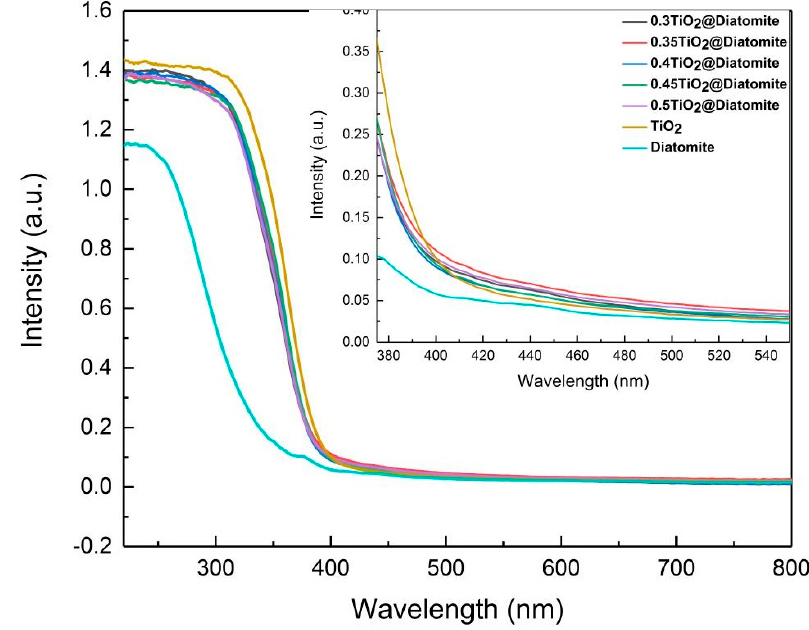
Figure 4. UV-visible diffuse reflectance adsorption spectra of the catalysts.